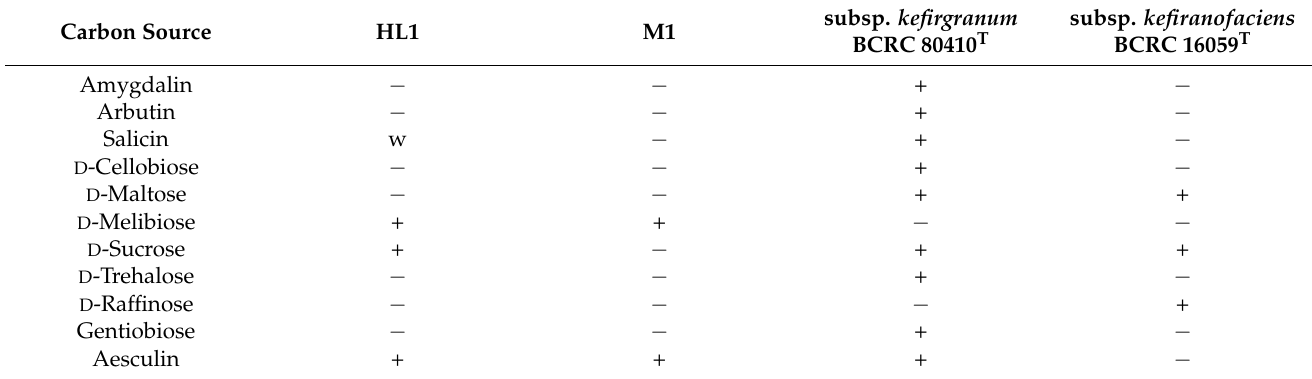
Table 1. Differential carbohydrate fermentation characteristics of L. kefiranofaciens strains HL1 and M1, and their closest related type strains by API 50 CHL system. +, Positive; − , negative; w, weakly positive. subsp. kefirgranum Carbon Source HL1 M1 BCRC 80410